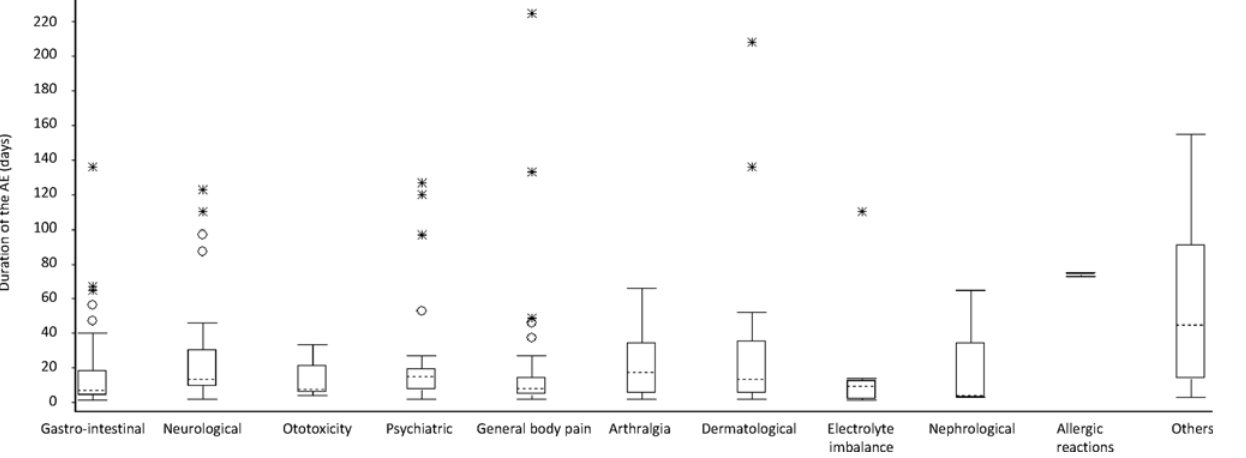
Fig 4. Duration of ADRs among MDR-TB patients admitted to in-patient care, Nigeria, 2012 – 2013.